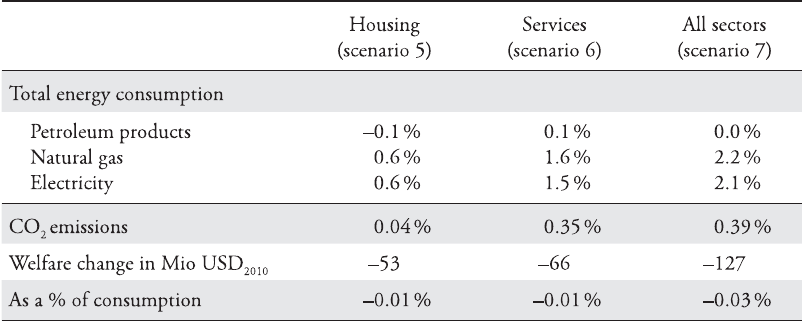
Table 5: Impacts of a Climate Change Induced Incre:ue in Cooling Electricity Consumption in 2060 (climate scenario AlB, %change with respect to the BAU